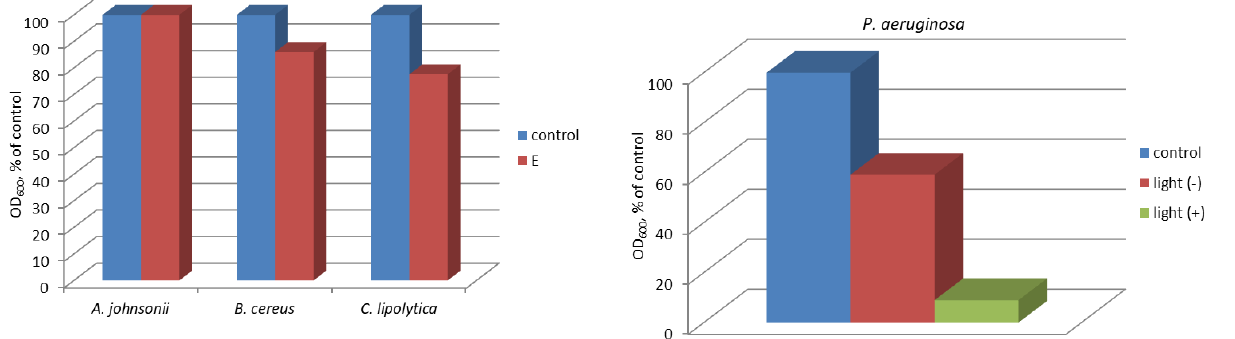
Figure 6: Effect of cotton fabric treated with compound E on growth development (quantified by OD at 600 nm) of the indicated model microbial strains.